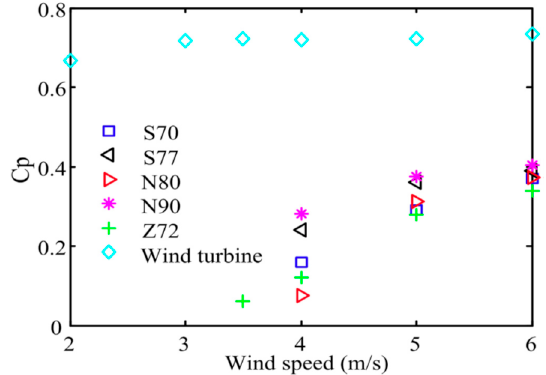
Figure 10. Comparison of wind turbine with shroud and lobed ejector with other different other turbines [115].